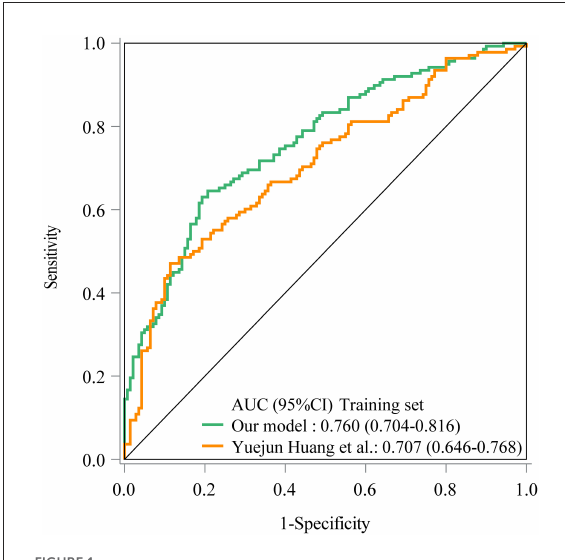
FIGURE1 The receiver operator characteristic (ROC) curve showed the predictive ability of the prediction model in the training set in our model and Yuejun Huang et al.’s model.